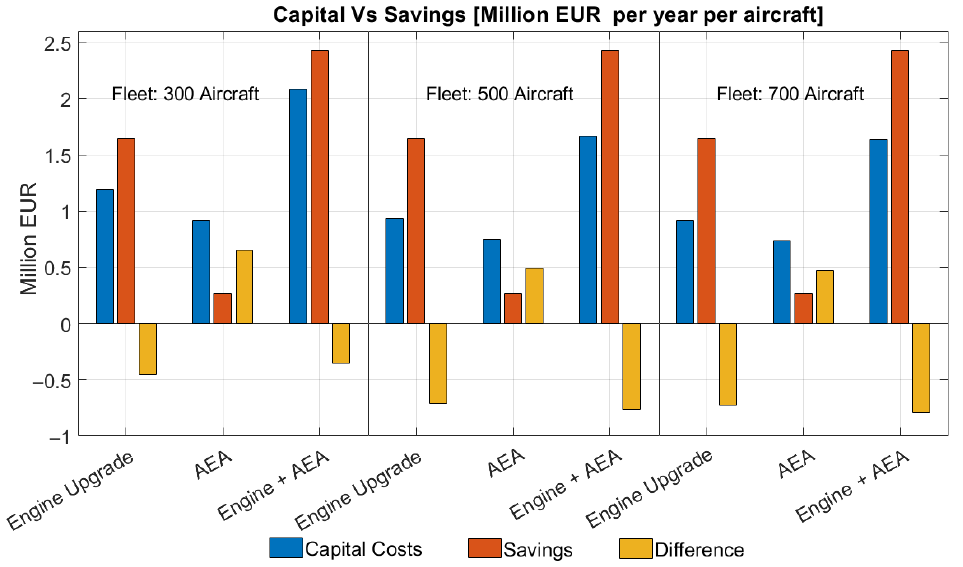
Figure 14. Capital costs and savings and the difference per year per aircraft. The fuel price considered is EUR 159 per barrel, +81%, as taken from Error! Reference source not found. .